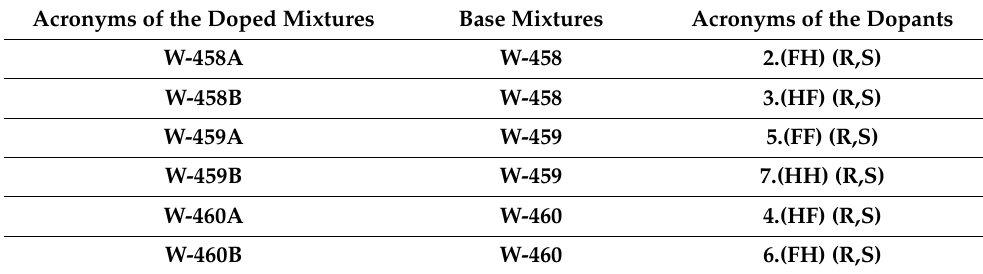
Table 3. The compositions of the six prepared mixtures.